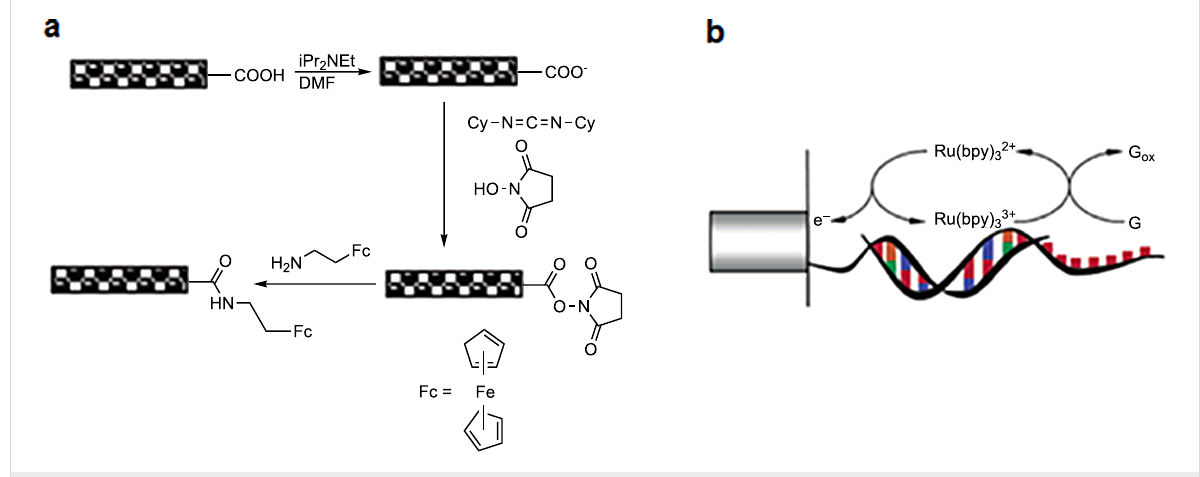
Figure 21: (a) The functionalization process of the amine-terminated ferrocene derivative to CNT ends by carbodiimide chemistry and (b) the schematic mechanism of Ru(bpy) 33+ -mediated guanine oxidation. Adapted with permission from [162]. Copyright 2003 American Chemical Society.